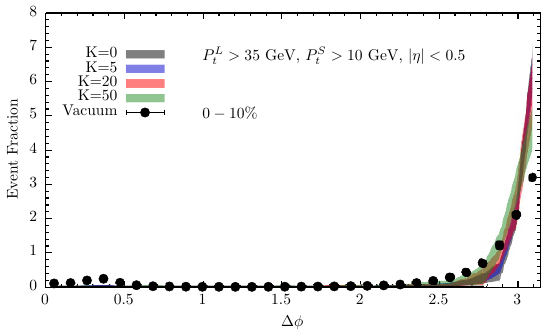
Figure 4 . Dijet acoplanarity distribution for dijets in heavy ion collisions at RHIC for di(cid:11)erent values of the broadening parameter K . For comparison, the black dots show the acoplanarity distribution in proton-proton collisions as simulated by Pythia